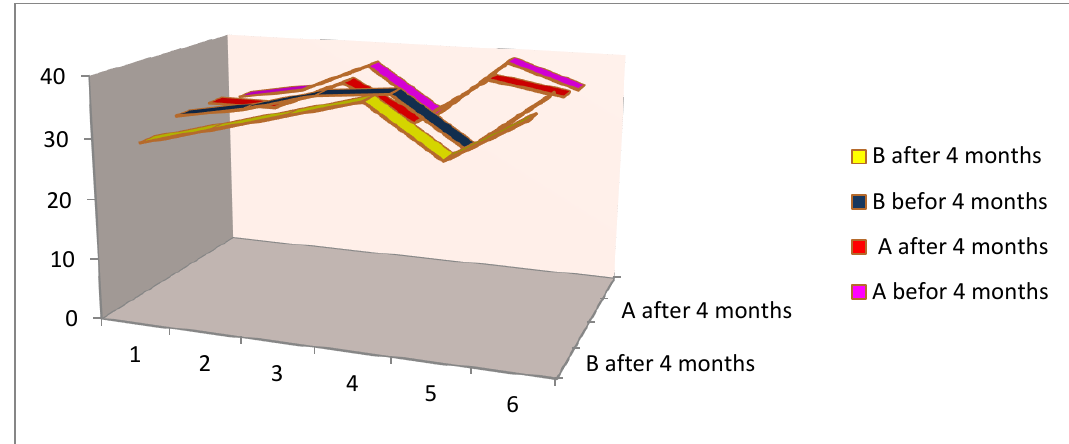
Fig. 1. Comparison of the two groups' mean HDL (mg/dl) with time (baseline and after four months)